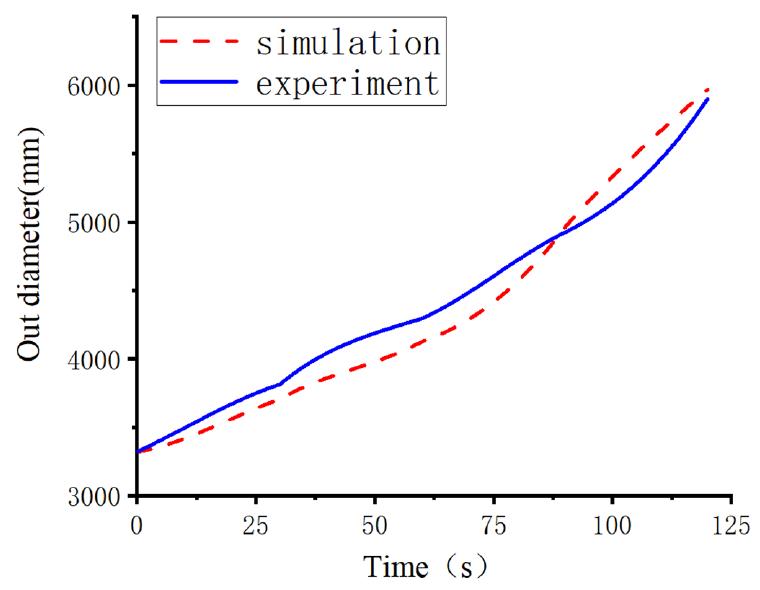
Figure 9. Outer diameter growth rate for simulation and experiment.